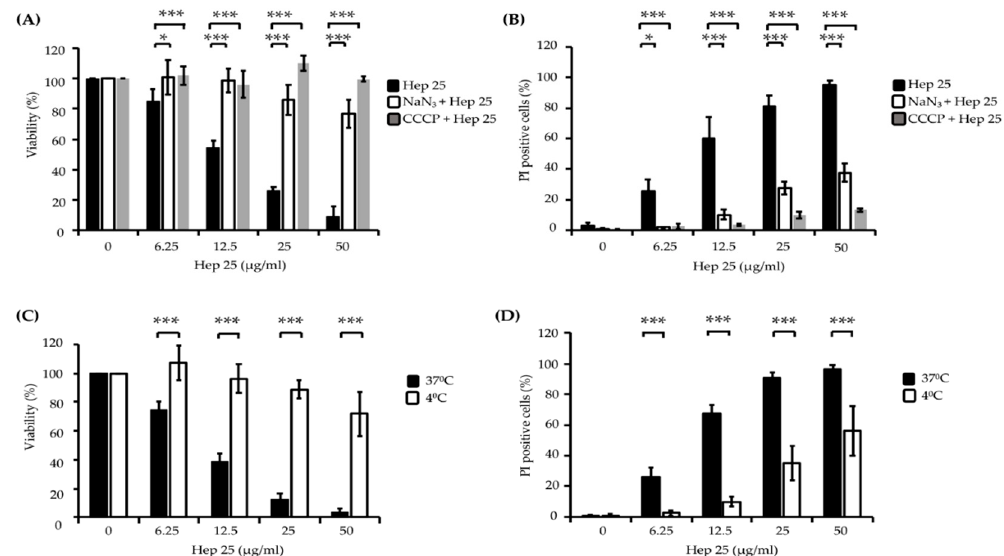
Figure 3. The effect of energy and temperature on the killing activity of hep 25. C. albicans cells were pretreated with 5 mM NaN 3 for 1 h or 50 μ M CCCP for 2 h at 30 °C to deplete cellular ATP, harvested by centrifugation, washed with sterile PBS and incubated with various concentrations of hep 25 at 37 °C for 90 min. ( A ) Cell viability was calculated by the number of CFUs and expressed as percentage with respect to the control cells (without hep 25 treatment). ( B ) Cells stained with PI were detected using a flow cytometer and expressed as percentages. C. albicans cells were treated with various concentrations of hep 25 at 4 °C for 90 min. ( C ) Candidacidal activity of hep 25 was determined by the number of CFUs and expressed as the percentage of viable cells. ( D ) The extent of hep 25-induced death as detected by PI staining. All the results are expressed as the mean ± standard deviation of three independent experiments; * p < 0.05 and *** p < 0.001.